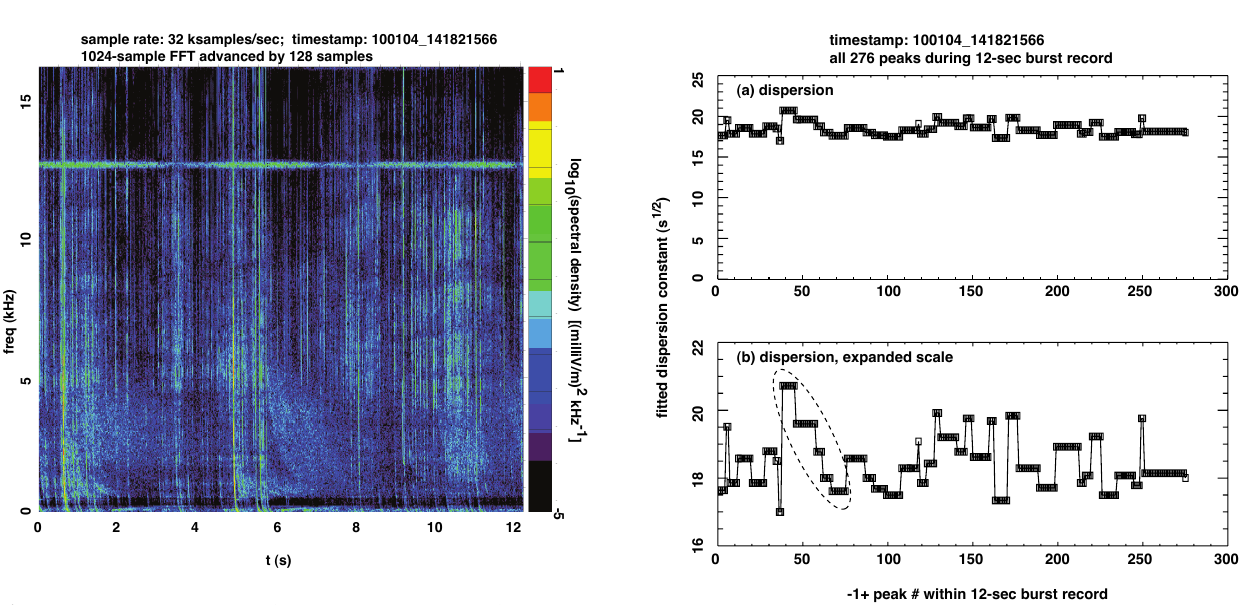
Fig. 8. Similar to Fig. 1, but for the burst recording of 4 January 2010 yielding the most peaks for that day.